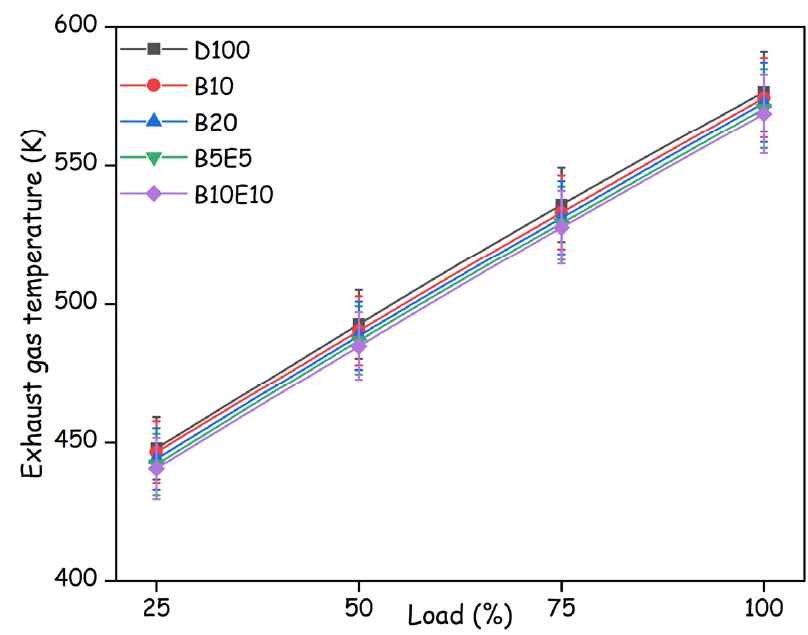
Figure 10. EGT of tested fuel blends against engine load.